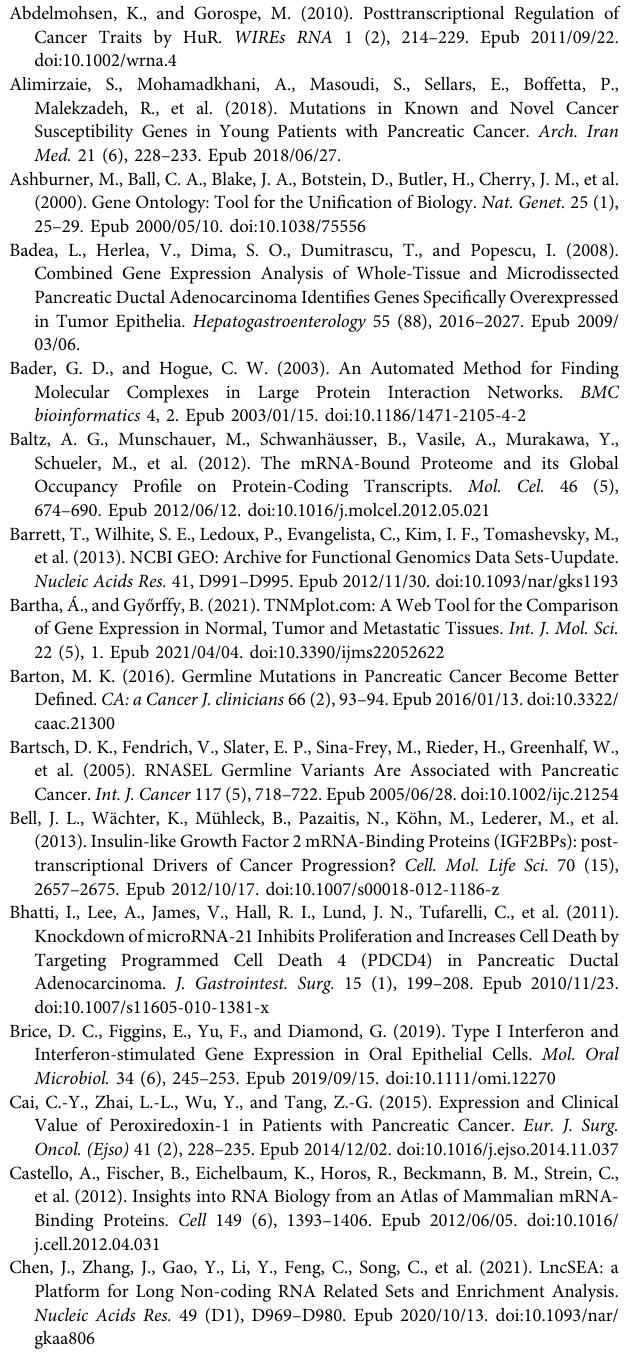
Supplementary Table S7 | GO term enrichment and KEGG pathway analysis results ofcoding targets ofselectedRBPs. Result ofGO enrichment forupregulated coding targets are shown in sheet 1 named as “ UP TARGET GO. ” KEGG pathway analysis results of upregulated coding targets are shown in sheet 2 named as “ UP